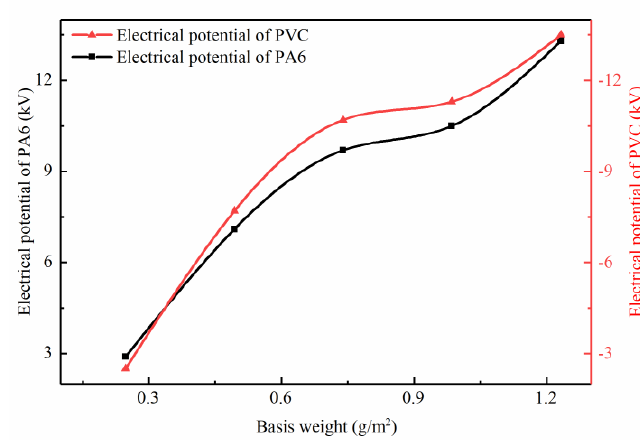
Figure 4. The electrical potential of the nanofiber membrane under an airflow velocity of 0.15 m/s.